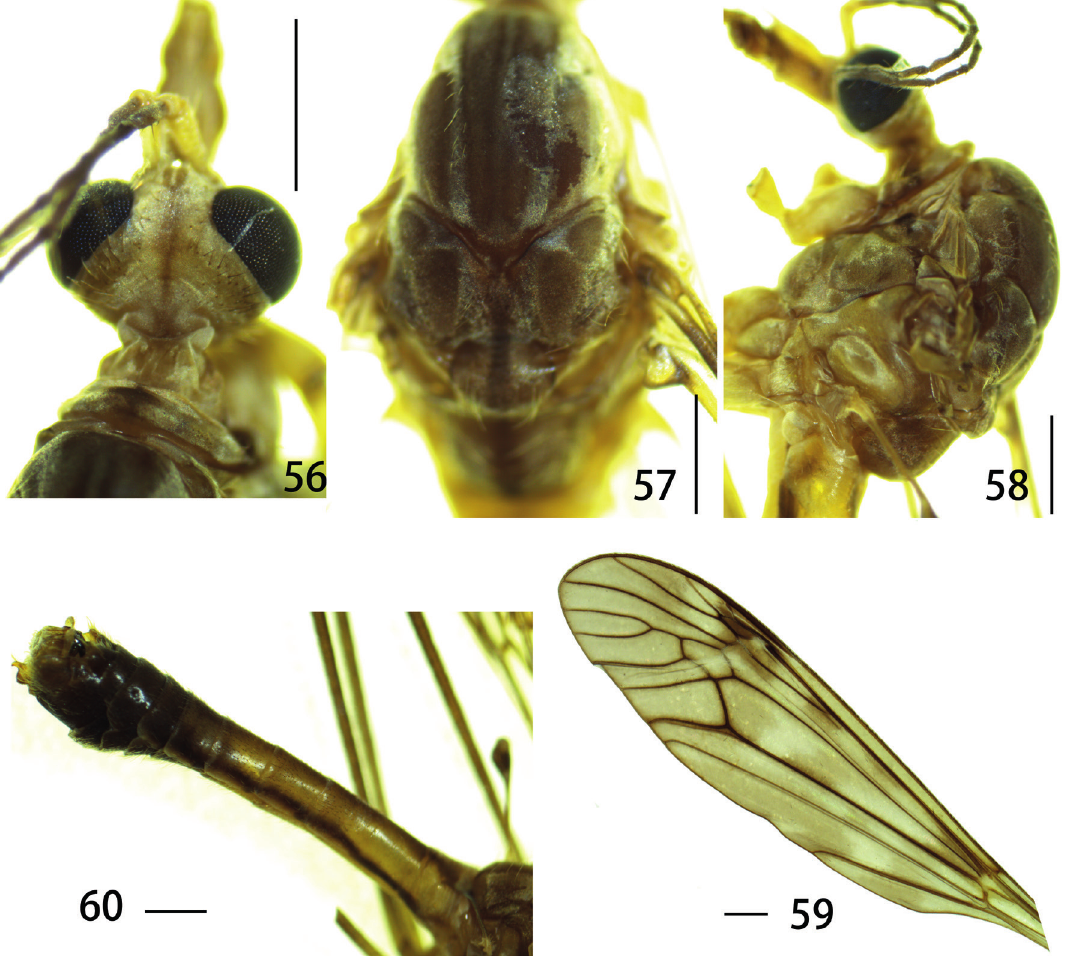
Figs 56–60. Tipula ( Vestiplex ) nestor Alexander, 1934, ♂, AQNU. 56 . Head, dorsal view. 57 . Thorax, dorsal view. 58 . Thorax, lateral view. 59 . Wing. 60 . Abdomen, lateral view. Scale bars = 1.0